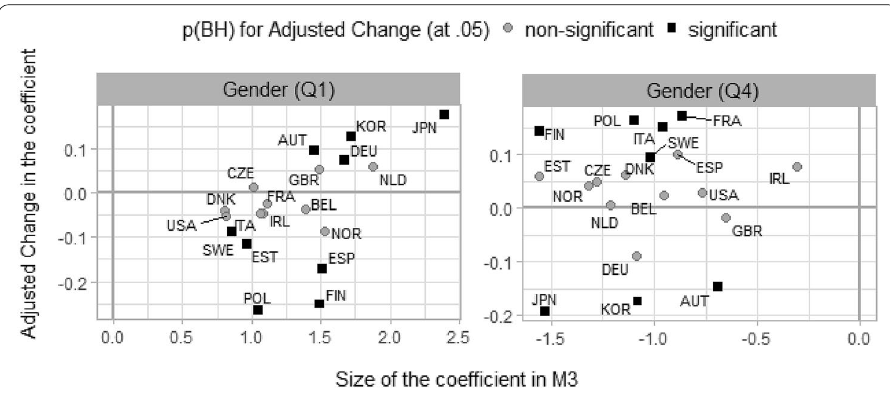
Fig. 3 KHB differences in coefficients of Gender against size of the coefficient in M3 (significance according to BH procedure indicated) [Q1 and